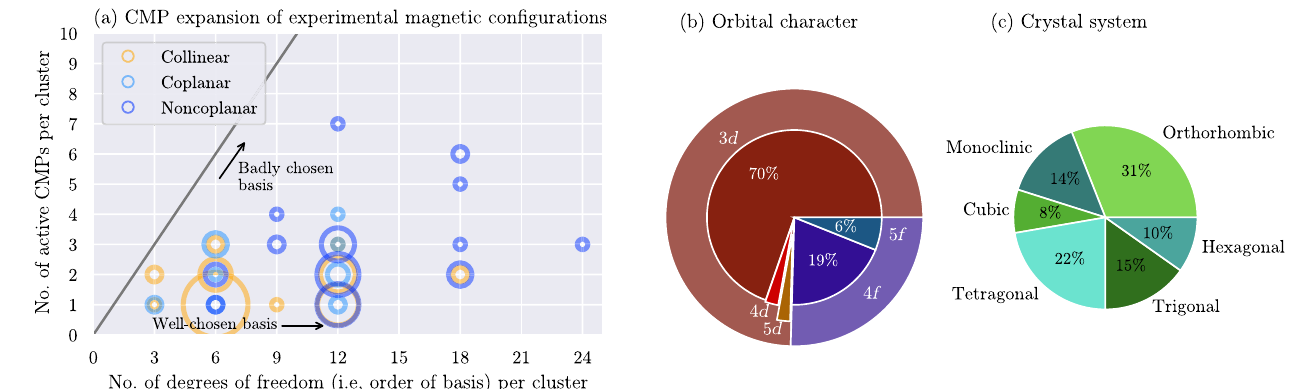
FIG. 1. Properties of 122 experimental magnetic configurations. (a) The number of CMPs needed to expand the experimental magnetic configuration — active CMPs — over the number of degrees of freedom per magnetic cluster. There are 3 N degrees of freedom for N sites in a magnetic cluster, which coincides with the order of the CMP basis. The size of the circle indicates the frequency of occurrence. (b) Orbital character of the magnetic site. (c) Crystal